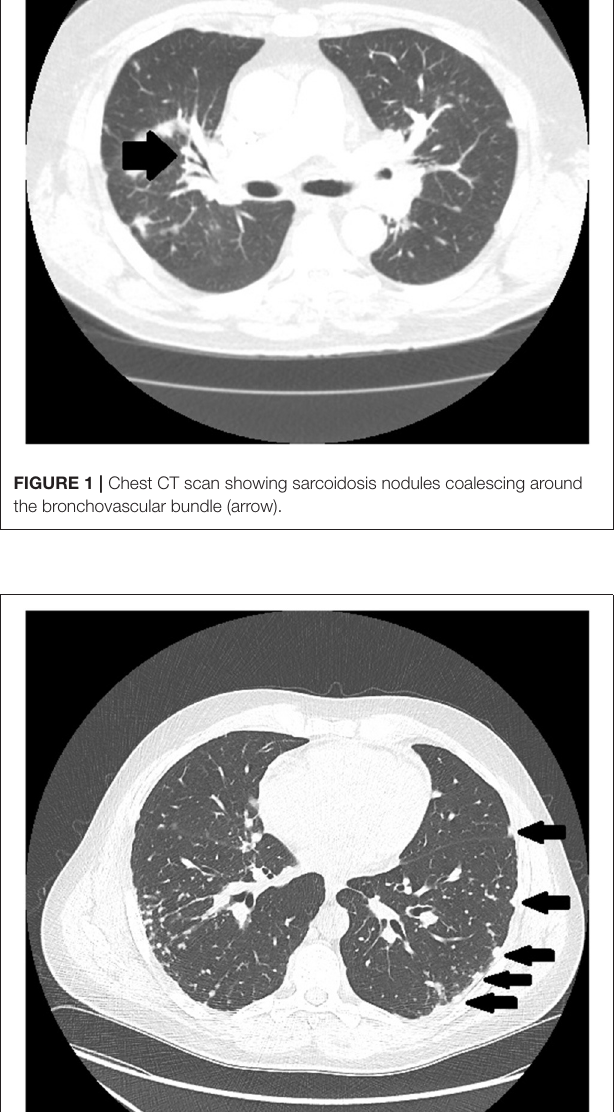
present as radiographic mimics of the disease, and present with identical radiographic findings listed in Table 3 and Figure 5 .